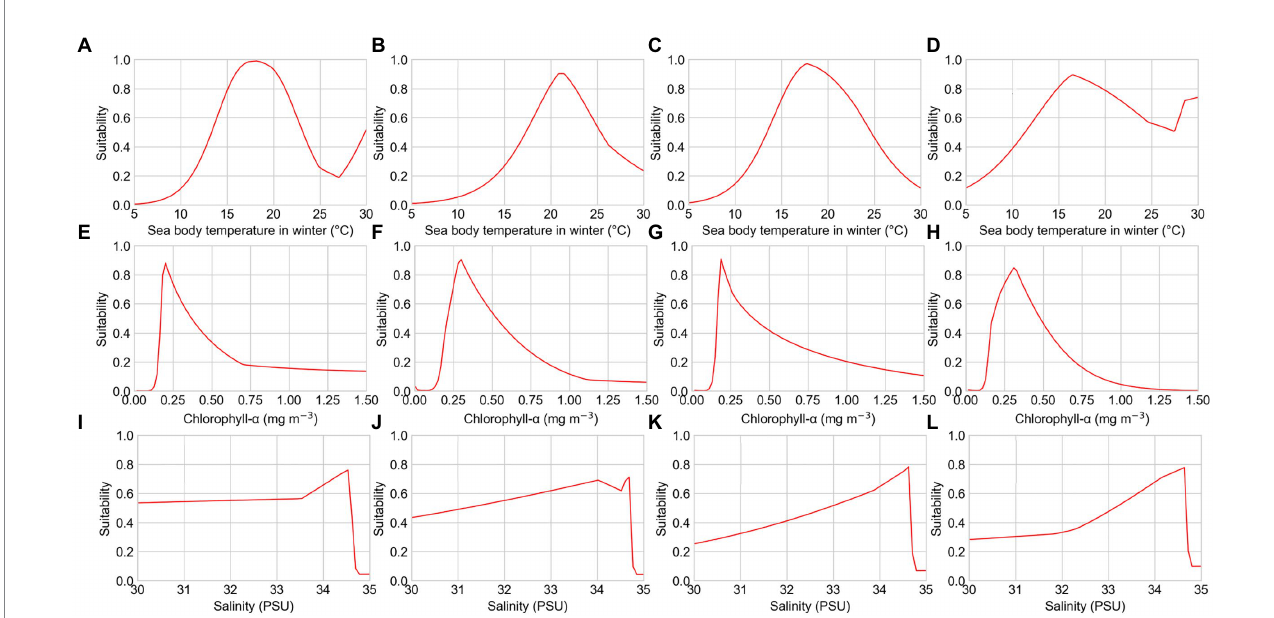
FIGURE 4 Response curves of several environmental factors affecting the distribution of reef-associated fish from the distribution tendency simulation. (A–D) Sea body temperature in winter of T1, T2, T3, and T4; (E–H) chlorophyll- α concentration of T1, T2, T3, and T4; and (I–L) seawater salinity of T1, T2, T3, and